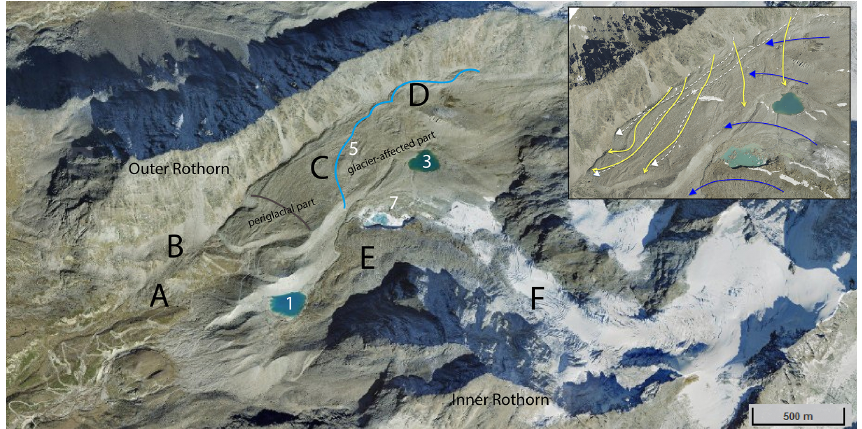
Figure 1. Geomorphological description of the Gruben site as shown in an orthophoto from 2017 (© SWISSIMAGE, geodata@swisstopo). The blue line indicates the approximate outline of Gruben glacier in the contact zone with the Gruben rock glacier at the time of the Little Ice Age (LIA). The grey line on the rock glacier indicates the position of a seismically determined subsurface bedrock riegel. Landforms: A = inactive but still frozen rock glacier; B = actively creeping, frozen protalus rampart; C = Gruben rock glacier; D = deformed frozen talus or moraine; E = debris-covered tongue of Gruben glacier; F = Gruben glacier; 1, 3, 7 = existing lakes; 5 = former thermokarst lake (lake numbering follows historical scheme in order to keep lake identities constant over time; see Fig. 4). The inset in the upper right (see full Fig. 1 for scale) shows the flow trajectories in frozen debris as determined by aero-photogrammetry with the yellow lines (see Fig. 14 in Haeberli et al., 1979; see Fig. S3) and flow trajectories in frozen debris (dashed white lines), which follow the surface structures produced by long-term cumulative deformation of the frozen talus. The blue arrows indicate the estimated flow direction of the LIA glacier as derived from the earliest reliable topographic map (1889; see Figs. S4, S5, and S6).